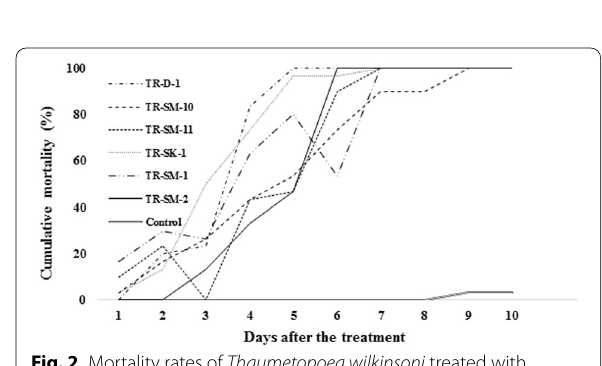
Fig. 2 Mortality rates of Thaumetopoea wilkinsoni treated with Beauveria bassiana and Beauveria pseudobassiana isolates at